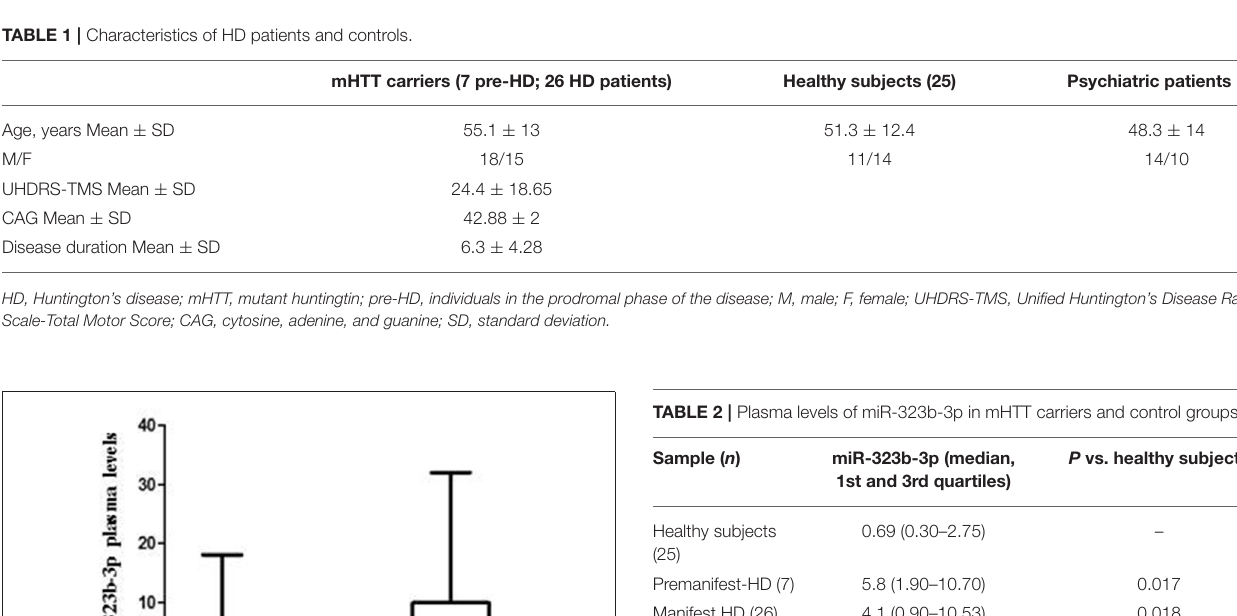
FIGURE 1 | HD-specific signature of circulating miRNA in HD subjects with respect to control groups (HS, healthy subjects; PP, psychiatric patients).